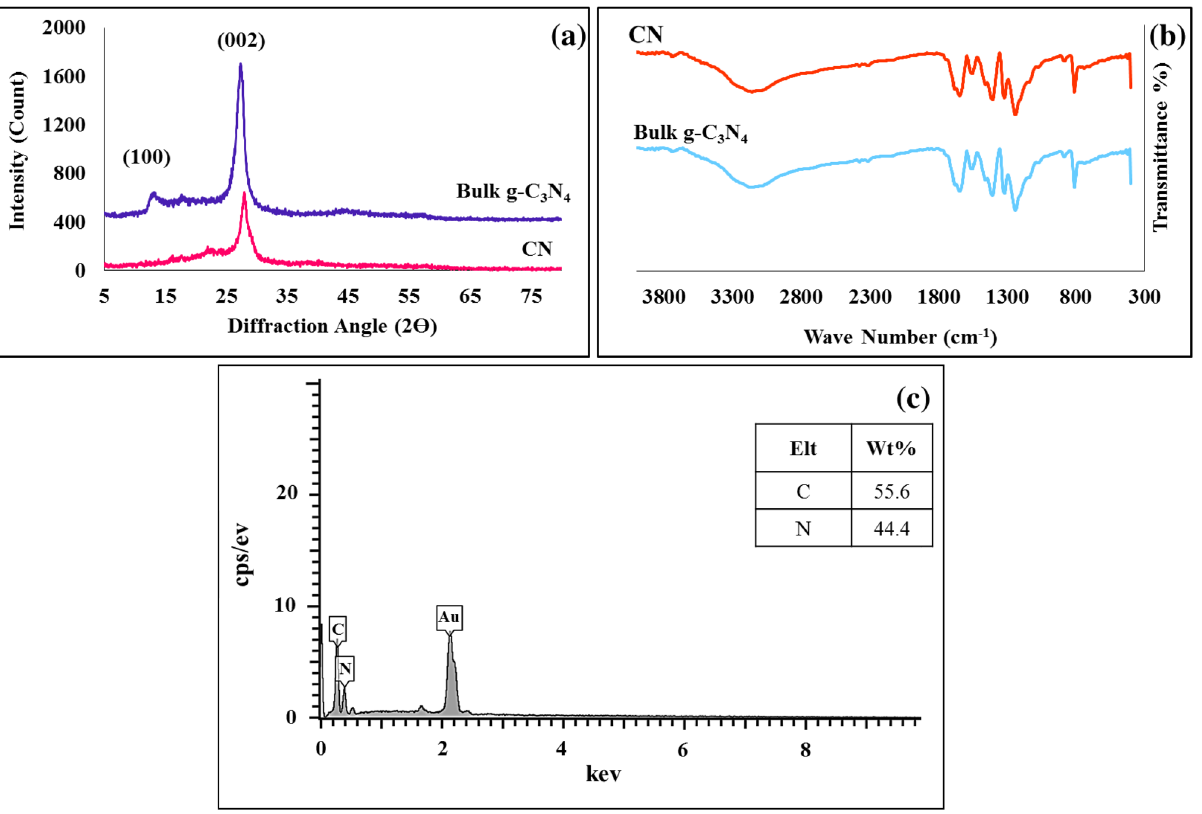
Figure 1. ( a ) XRD patterns and ( b ) FT-IR spectra of bulk g-C 3 N 4 and CN. ( c ) EDS spectrum of the